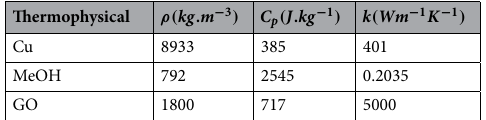
Table 4. Material properties of base fluid and nanoparticles at 293